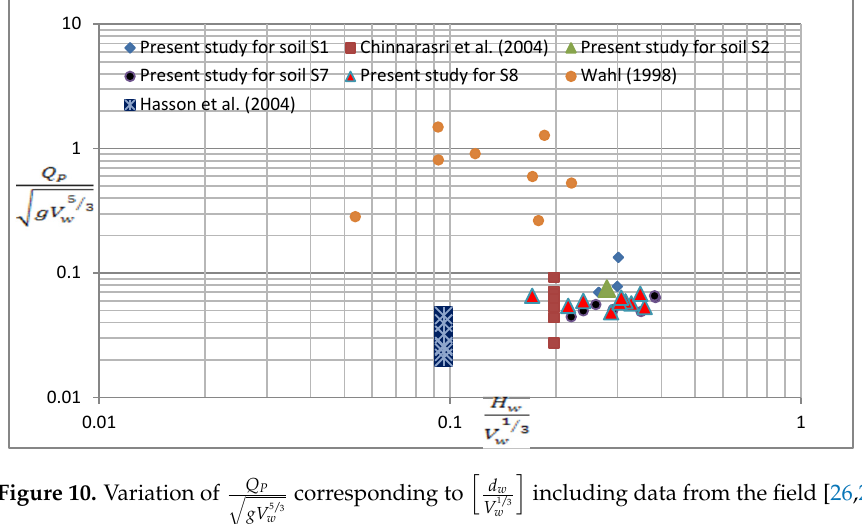
corresponding to gV 5 / 3 w